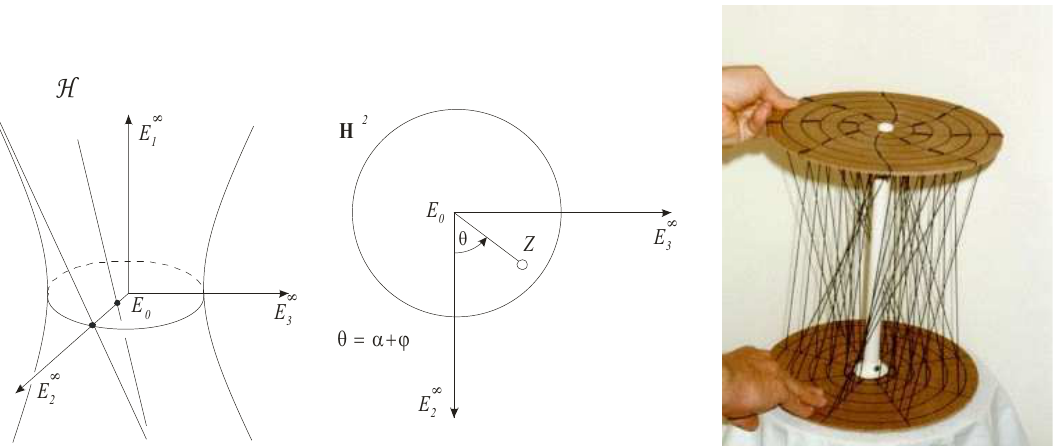
Figure 3. The unparted hyperboloid model of (cid:103) SL 2 R = (cid:101) H of skew line fibres growing in points of a hyperbolic base plane H 2 . In addition, a Gum-fibre model of Hans Havlicek and Rolf Riesinger, used also by Hellmuth Stachel with other respects (Vienna